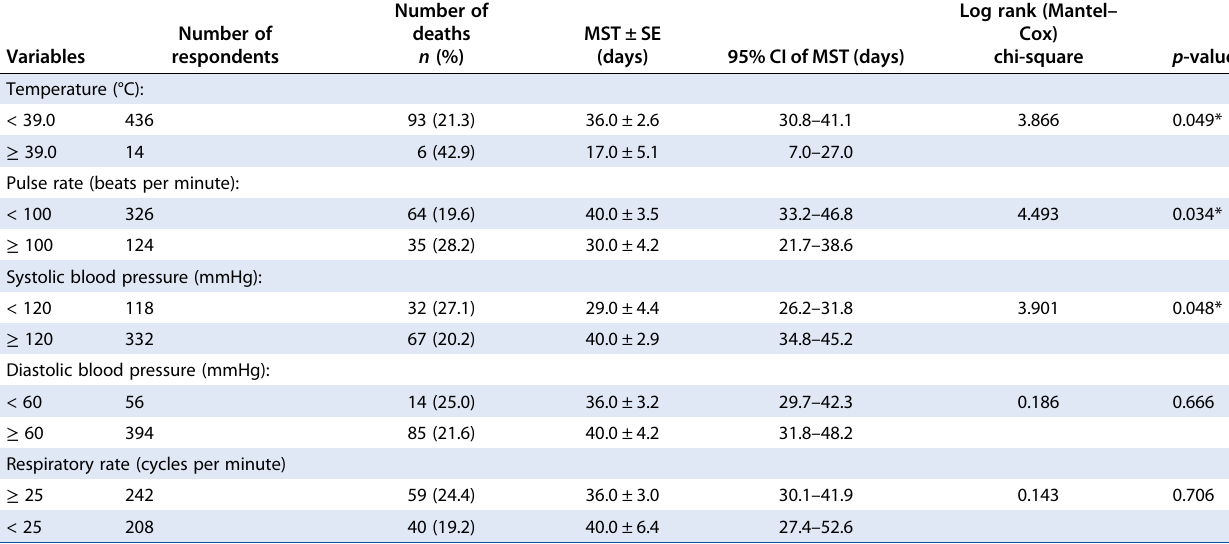
Table 2: Median survival times of hospitalisation by vital signs on admission